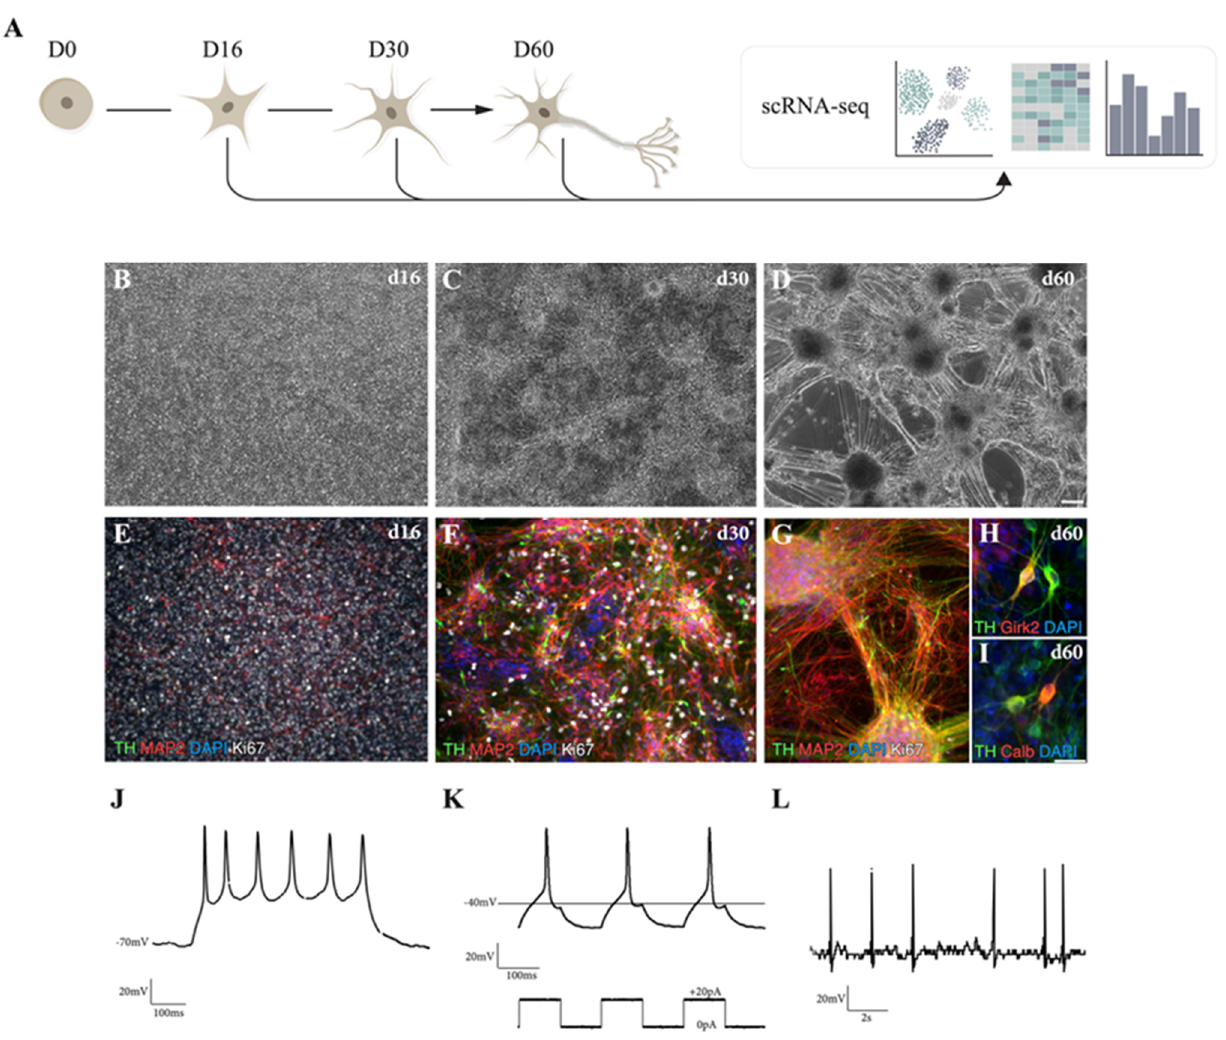
Figure 1. VM-patterned hPSC differentiation generates functionally mature dopaminergic (DA) neurons. ( A ) Schematic overview of the experimental design. ( B – D ) Representative bright-field images of ventral midbrain (VM) differentiation cultures at different time points (16, 30, and 60 days). Scale bars, 100 μm. ( E – G ) Immunofluorescence staining of tyrosine hydroxylase (TH), MAP2, and Ki67 at days 16, 30, and 60. Scale bars, 100 μm. Nuclei were stained with 4′,6-diamidino-2- phenylindole (DAPI). ( H ) Immunofluorescence staining of DA markers TH/GIRK2. ( I ) TH/calbindin (CALB) at day 60. Scale bars, 25 μm. Nuclei were stained with DAPI. ( J – L ) Electrophysiological assessment of DA neuron-rich cultures using patch-clamp analysis. ( J ) Cells analyzed at day 60 displayed induced action potentials. ( K ) Induced action potentials upon brief depolarization. ( L ) Spontaneous firing characteristic of DA neurons.